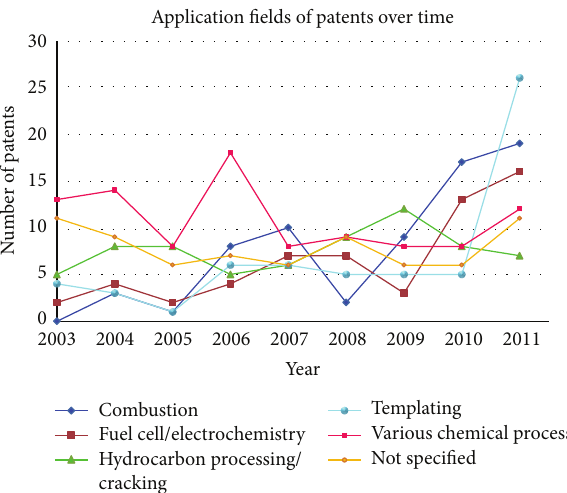
Figure 6: Development of application fields of patents